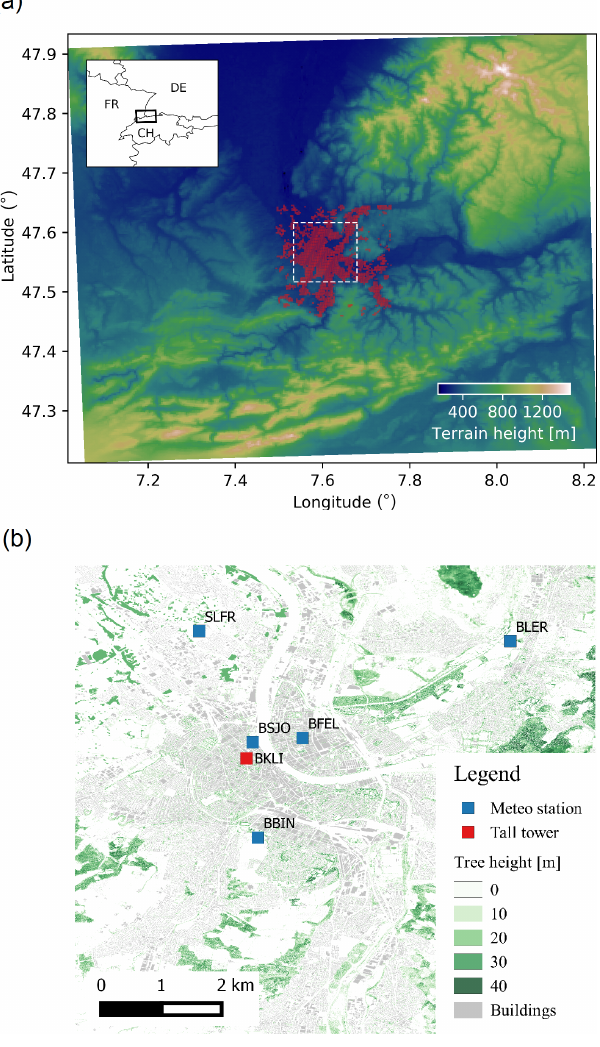
Figure 3. (a) The model domain centred over the metropolitan area of Basel. The terrain height (in ma.s.l.) is shown in the background. The urban area is highlighted in red. (b) Details of the urban area (corresponding to the dashed rectangle in panel a ) with the loca- tion of the measurement sites used for the evaluation (Sect. 3). In the background are the tree height distribution (green) (Geoportal Kanton Basel-Stadt, 2019) and building geometries (grey).